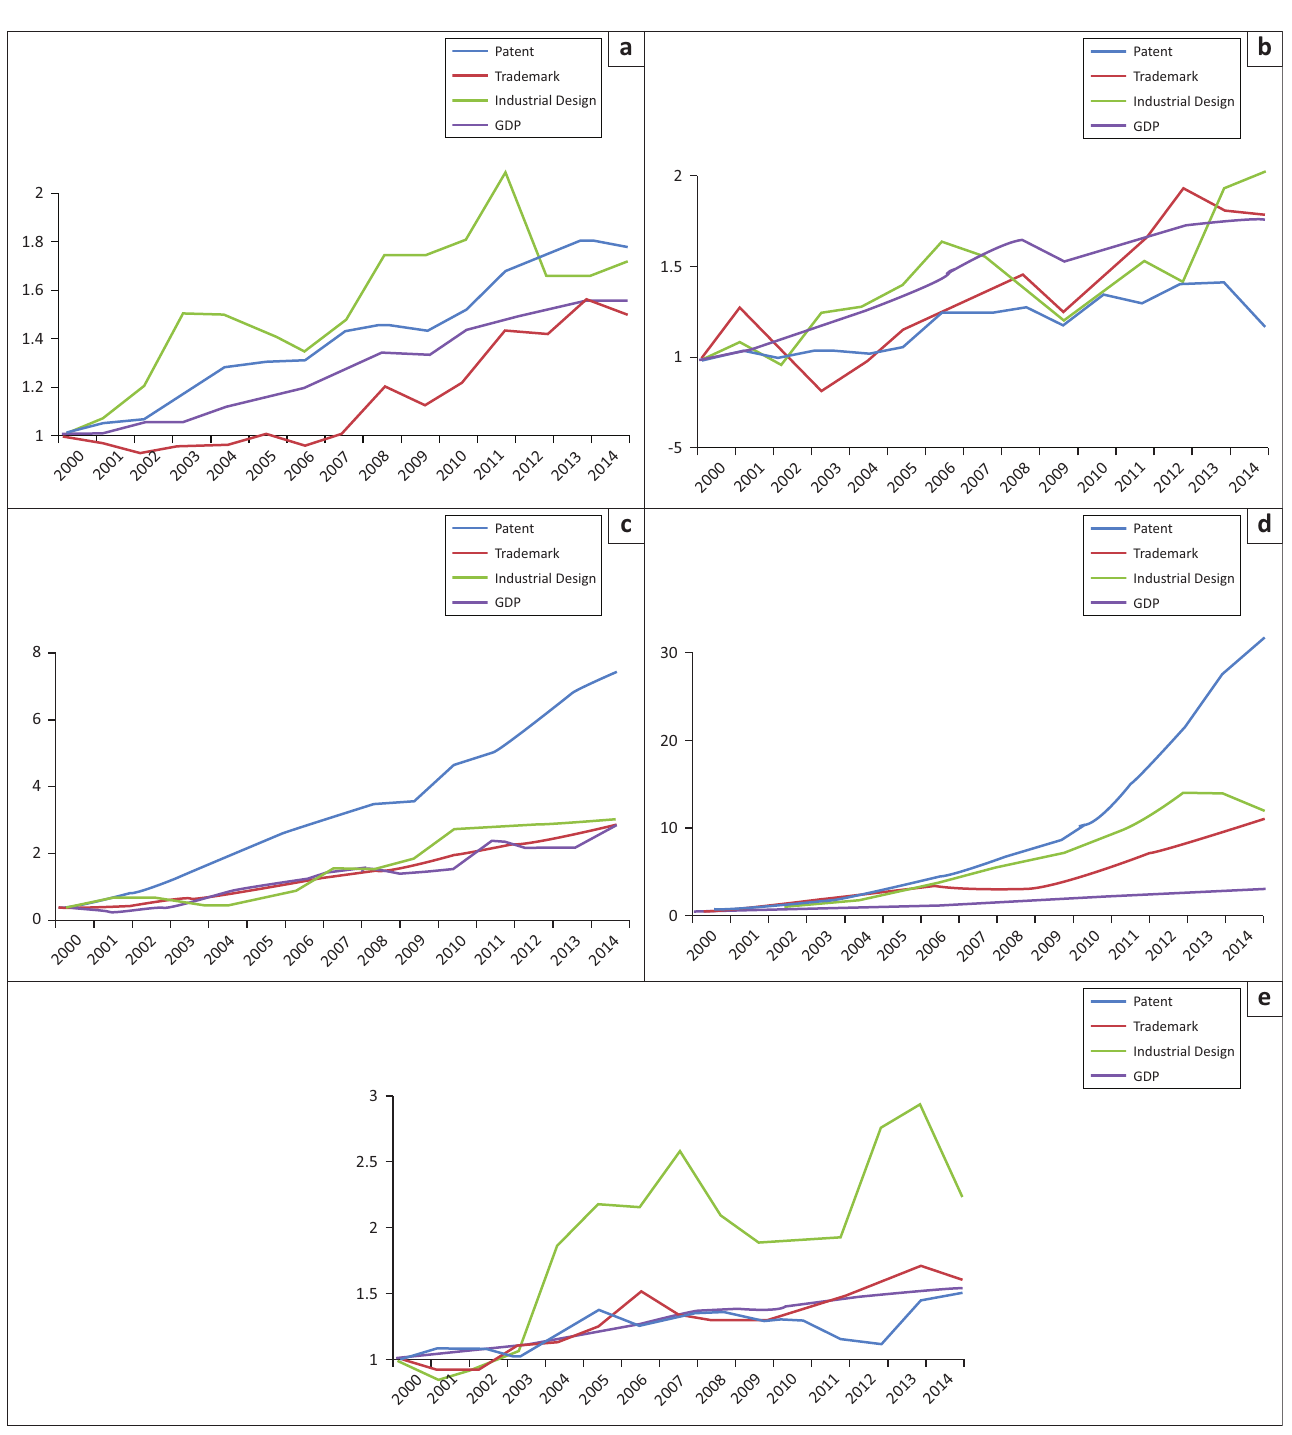
FIGURE 1-A1: Intellectual property filings and economic growth for (a) Brazil, (b) Russia, (c) India, (d) China and (e) South